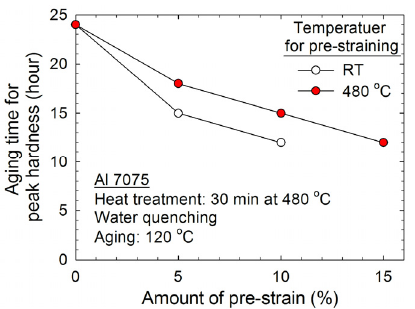
Figure 6. Plot of the optimal aging time for the peak aging hardness versus the amount of pre-strain.